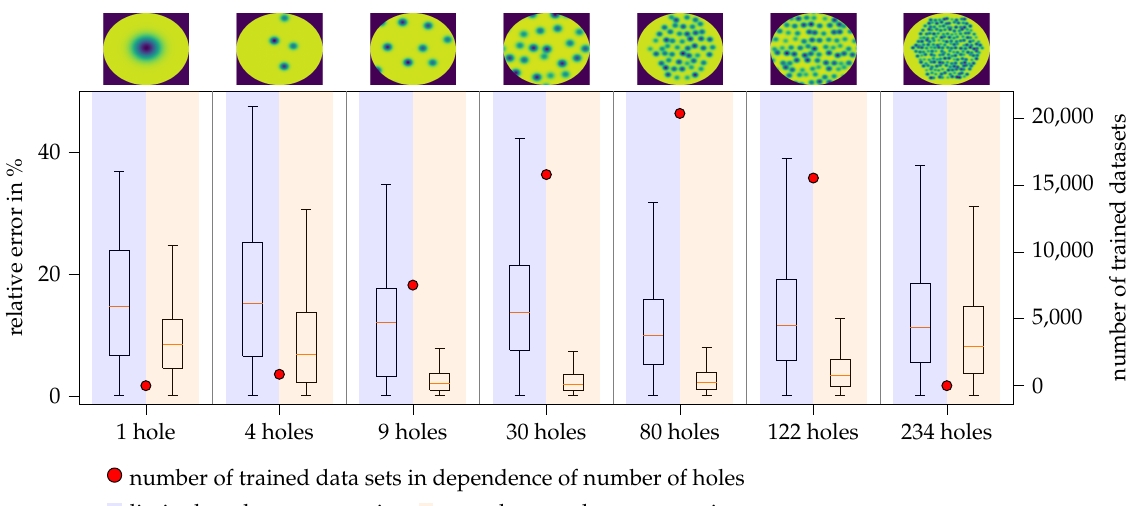
Figure 10. Limited angle and neural network extrapolated error distribution of tomographic reconstruction in dependency of model